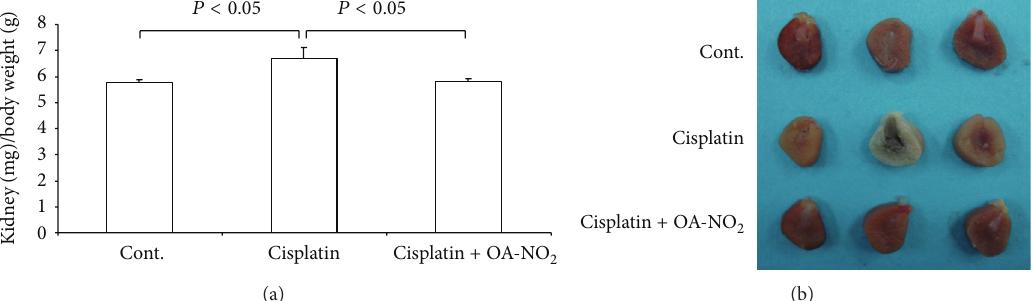
Figure 1: Pretreatment with OA-NO 2 attenuated the kidney swelling (a) and improved the kidney appearance (b). Cont.: 𝑁 = 6 ; cisplatin: 𝑁 = 13 . Data are mean ± SE. 𝑁 = 12 ; cisplatin + OA-NO 2 :